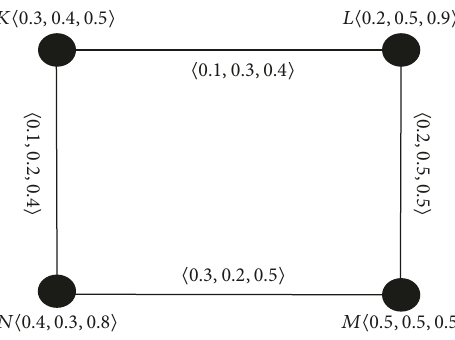
Figure 4: A highly irregular 𝑚 -polar fuzzy